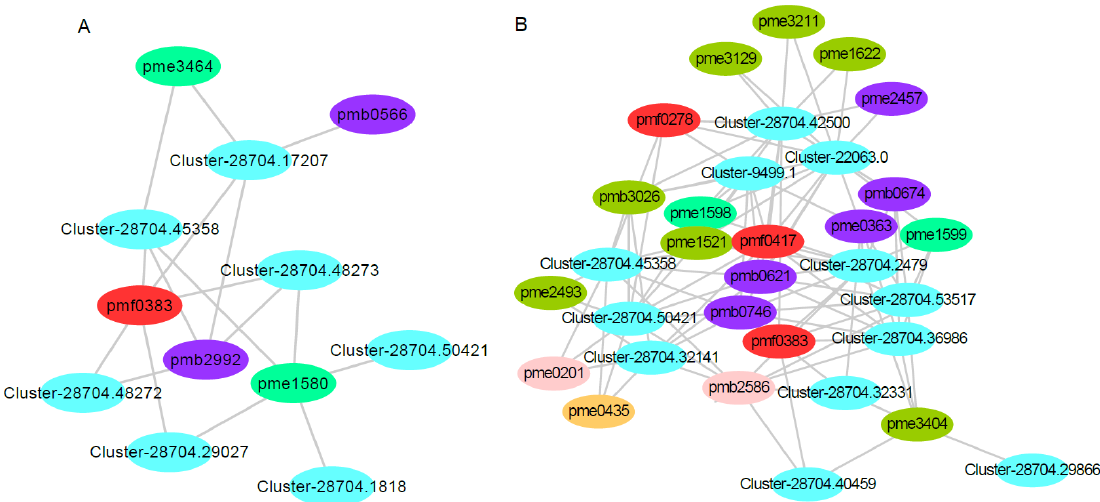
Figure 10. Correlation analysis of the transcriptomic and metabolomic data for red and yellow leaf coloring in red maple. Note: ( A ) the connection network between the DEGs and DAMs that mapped onto flavonoid metabolism in the red-strain red maple. Pmf0383, pmb2992, pme3464, pme1580, and pmb0566 are the metabolites of ‘5,7 -dihydroxy- 3′,4′,5′ - trimethoxyflavone′, acacetin O -glucuronic acid, isosakuranetin (4′ -Methylnaringenin), eriodictyol, and luteolin O -hexosyl- O -pentoside, re- spectively. ( B ) The connection network between the DEGs and DAMs that mapped onto flavonoid metabolism in the yellow-strain red maple. Pmb0621, pmb2586, pmb3026, pme1521, pme1598, pme1622, pme2457, pme3129, pme3211, pme3404, pmf0278, pmf0417, pmb0674, pmb0746,